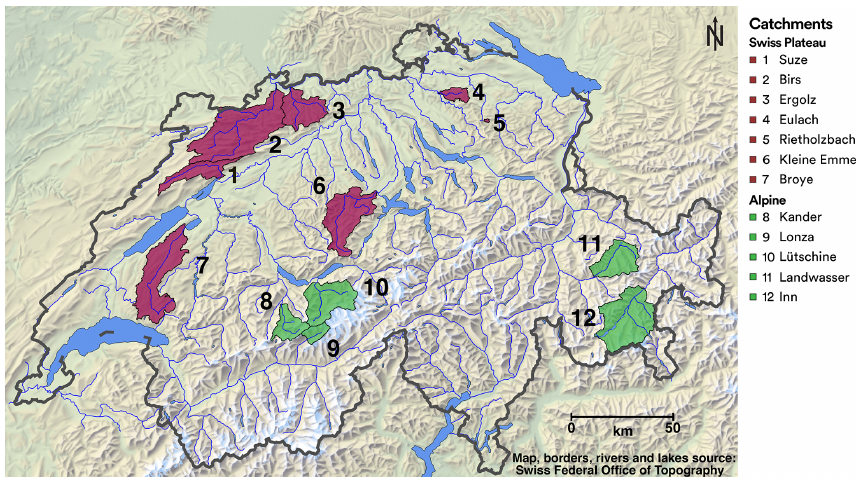
Figure 1. Map of Switzerland showing the location of the simulated catchments. Maps providing details of individual catchments are shown in Fig. S1. Data source: Swiss Federal Office of Topography